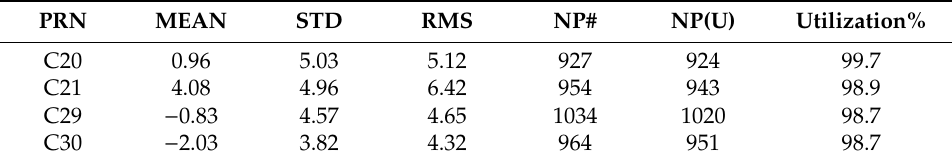
Table 8. The satellite laser ranging (SLR) validation accuracy (MEAN, STD, RMS) of the BD3 MEO satellite’s orbit (units: